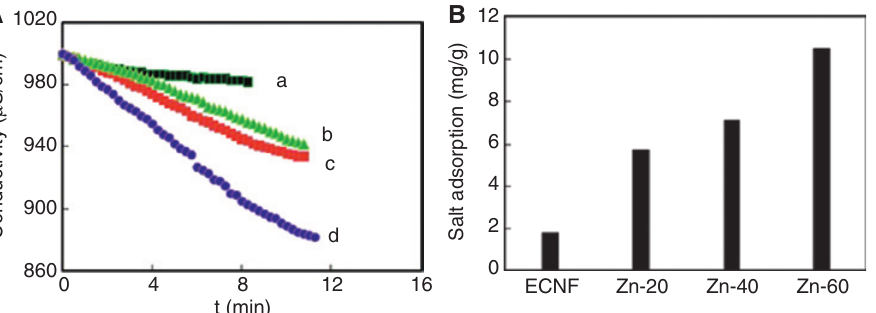
Figure 19: (A) Ionic adsorption behavior of PAN-based ACF (a) and Zn-ACF (b–d) electrodes in CDI cell in 500 mg/l of NaCl solution. Curves b–d correspond to Zn-20, Zn-40, and Zn-60, respectively. (B) The salt adsorption per cycle on different electrodes derived from the average of five charging-discharging cycles. For details, see Ref. [84]; reprinted with permission from